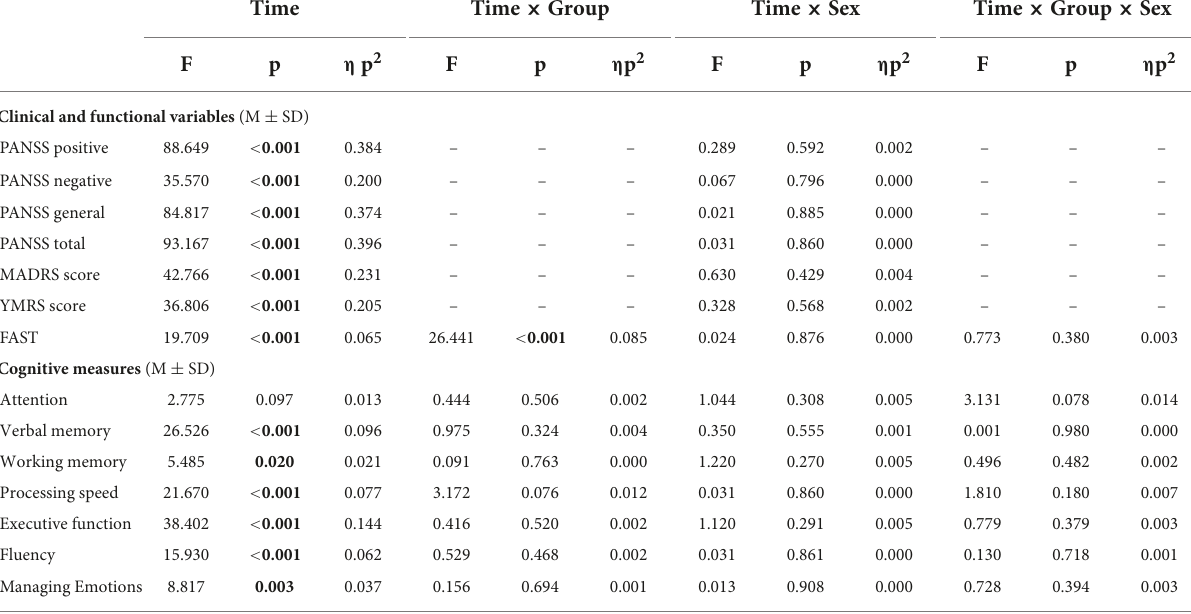
TABLE 2 Changes in clinical, cognitive functions and psychosocial